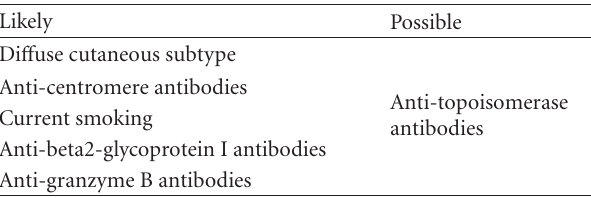
Table 1: Potential risk factors for digital ischemic loss in patients with systemic